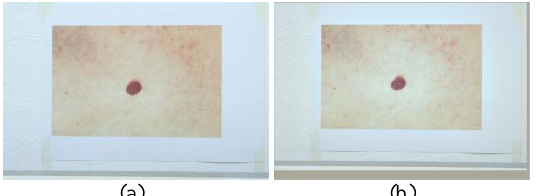
Figure 4. Homomorphic filter applied to test image#1 (a) Original Test Image#1 (b) Homomorphic Filtered Image: RGB strength 1.50